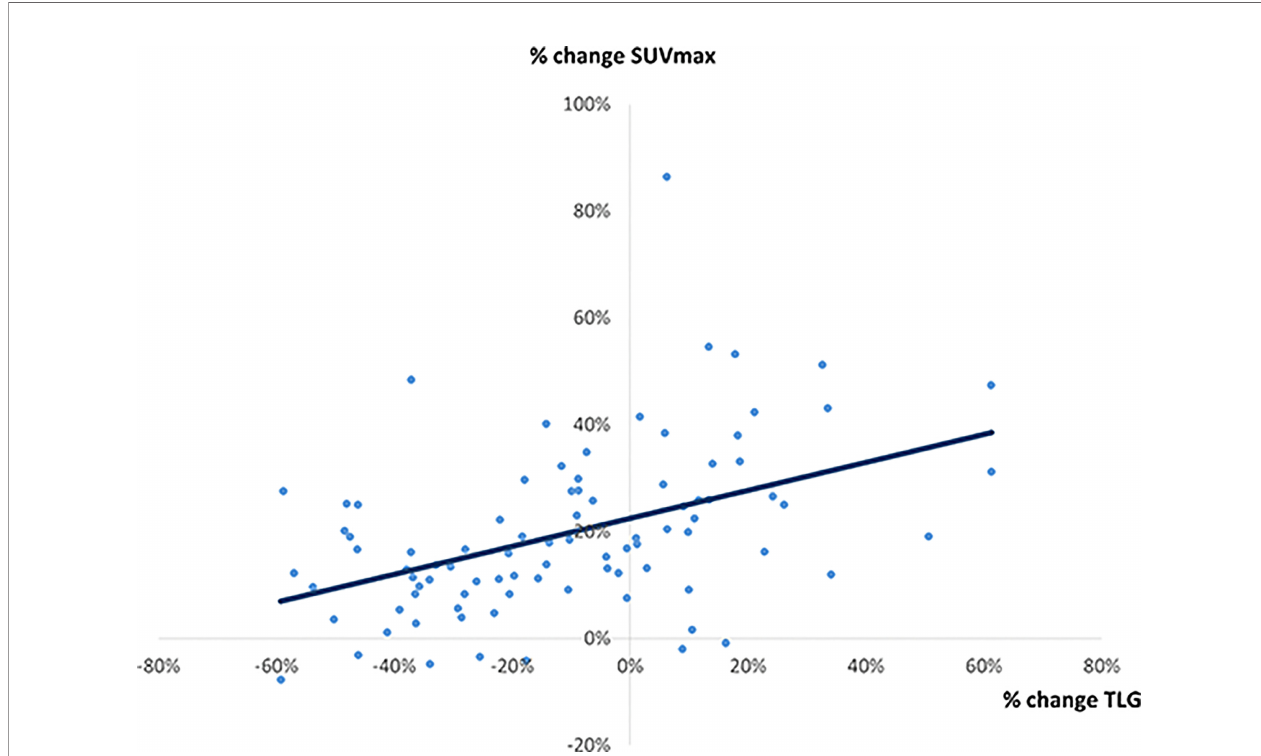
FIGURE 6 | A correlation between % change in SUV max and % change in TLG. A weak correlation was observed (r = 0.4522, p < 0.0001, y = 0.262x +